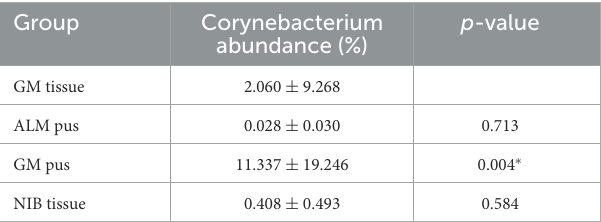
TABLE 4 Comparison between the GM tissue group and the other three groups.